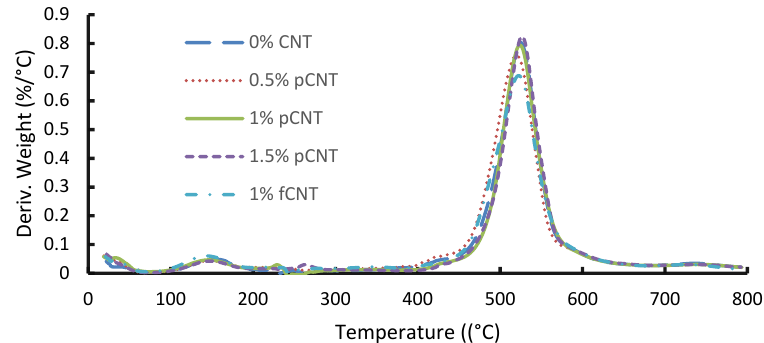
Figure 2. Thermographs of blended PSF / PES membranes with di ff erent CNT concentrations.